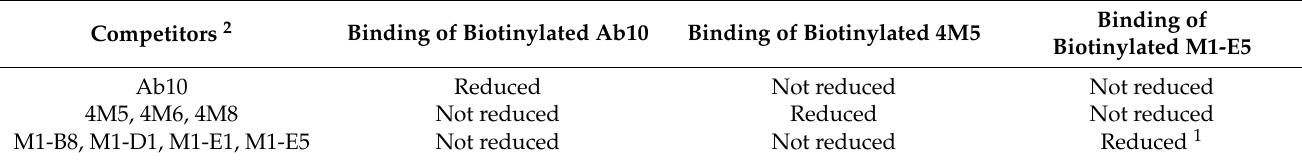
Table 3. Competition ELISA with anti-Gn mAbs 1 .